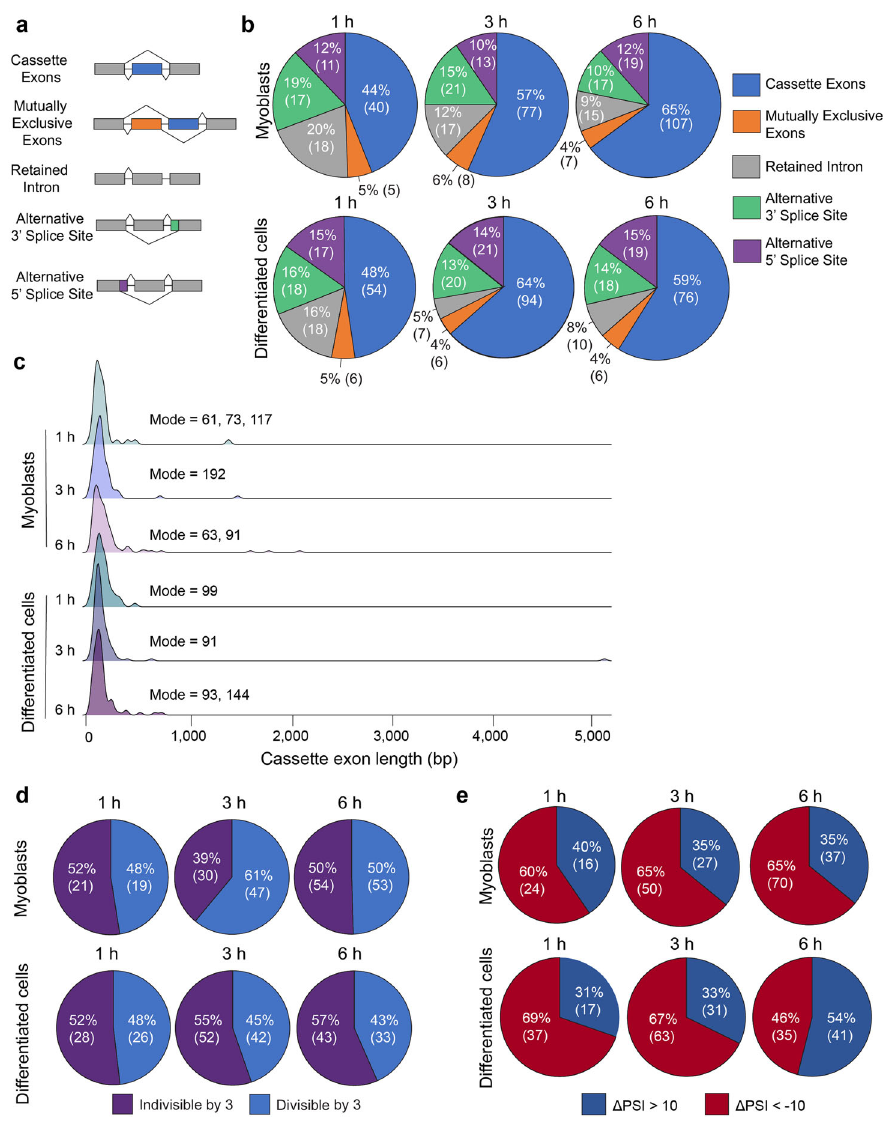
Fig. 5 Alternative splicing changes in response to stretching occur mostly in cassette exons. a Schematic showing the different type of splicing events. b Distribution of the splicing events depending on their type in myoblasts ( top ) and differentiated cells ( bottom ). The numbers between parentheses indicate the number of splicing events. c Density plots of cassette exon length in myoblasts ( top ) and differentiated cells ( bottom ). The mode(s) of cassette exon length is shown next to each plot. d Proportion of cassette exons that are indivisible by three (purple) or divisible by three (blue) in myoblasts ( top ) and differentiated cells ( bottom ). The numbers between parentheses indicate the number of splicing events. e Proportion of splicing events that underwent more inclusion ( Δ PSI > 10, blue) or more exclusion ( Δ PSI < − 10, red) of the alternatively spliced region upon stretching. The numbers between parentheses indicate the number of splicing events. The Δ PSI was de fi ned as the difference between the PSI in stretched samples and the PSI in the non- stretched controls. PSI percent spliced